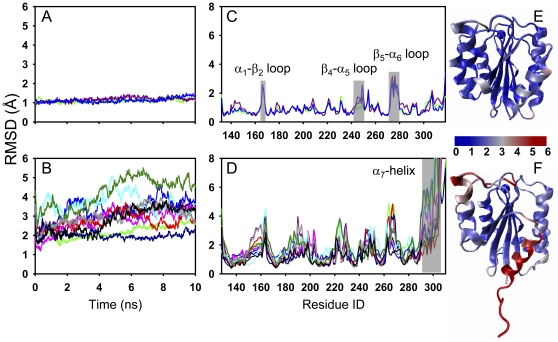
Conformational stability comparison between LA LFA-1 and LA Mac-1 I domains.Global RMSDs (A, B) and average RMSDs of each residue over time (C, D) are presented for three equilibration runs of LA Mac-1 I domain (A, C) and ten runs of LA LFA-1 I domain (B, D), respectively. Slightly flexible regions of α1-β2, β4-α5 and β5-α6 loops for LA Mac-1 I domain are labeled in C, and the most flexible region corresponding to α7-helix of E293 to K305 for LA LFA-1 I domain are labeled in D. Colored lines are denoted as the different trajectories and grey stripe(s) indicates those residues with remarkable or moderate conformational flexibility. Stability difference of each residue is illustrated for LA Mac-1 (E) and LA LFA-1 (F) I domains, using changed color from blue to red with corresponding RMSD value from 0 to 6 Å in their respective structures.